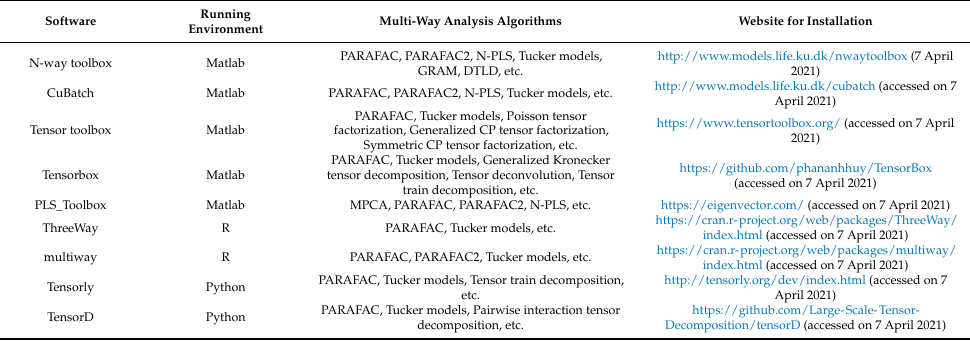
Table 3. Free and commercial multi-way analysis